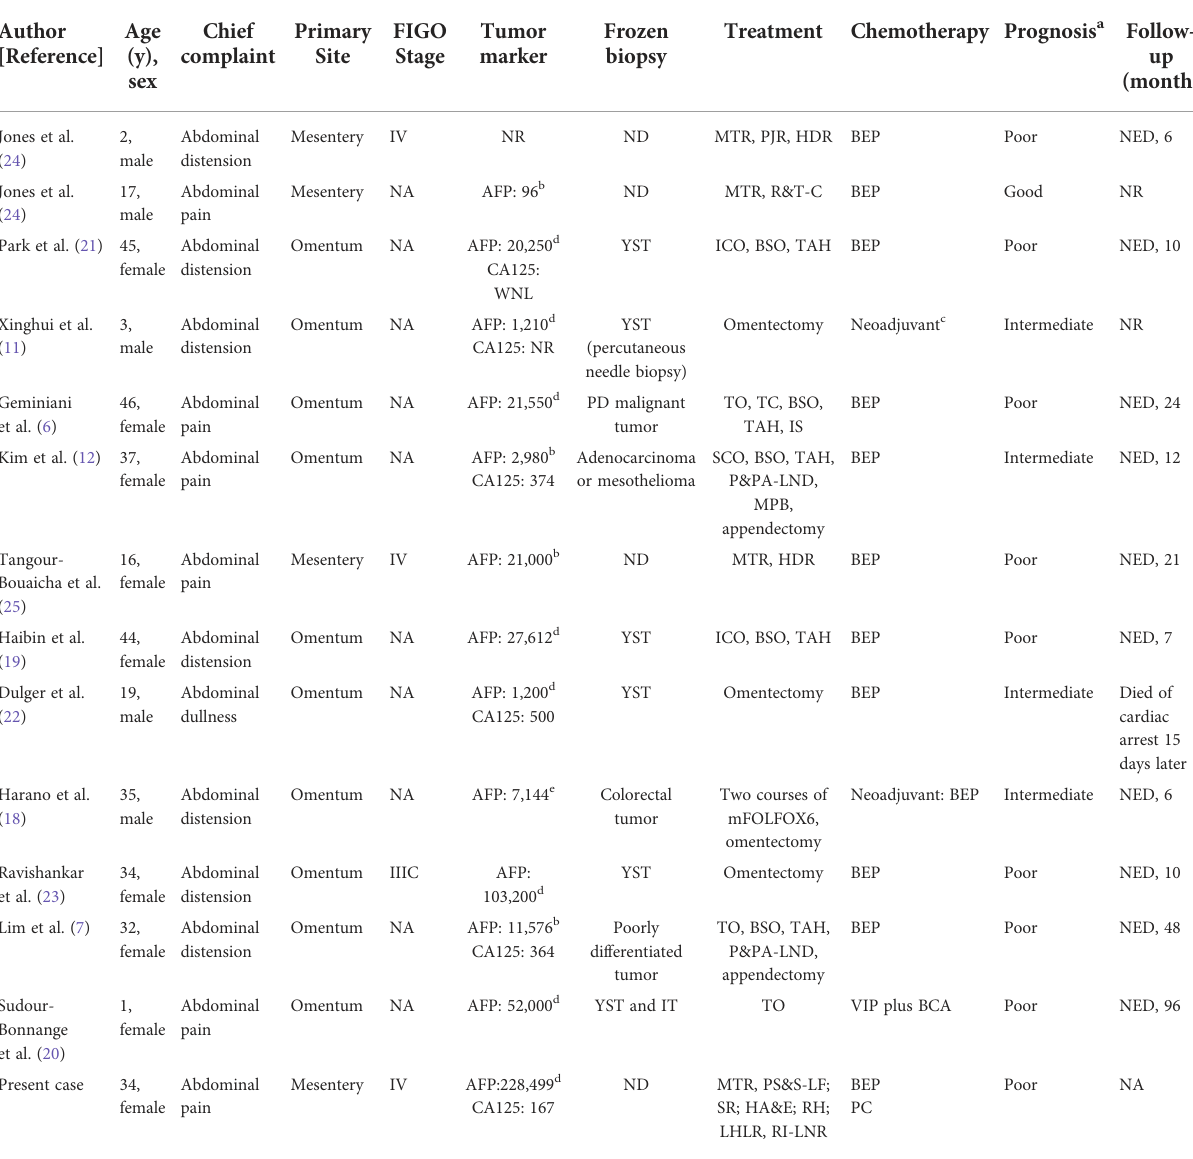
TABLE 1 Clinicopathologic features of reported cases of pelvic extragonadal